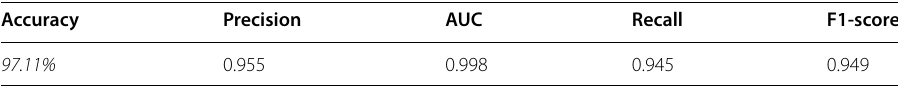
Table 3 Experimental results—qualitative characteristics